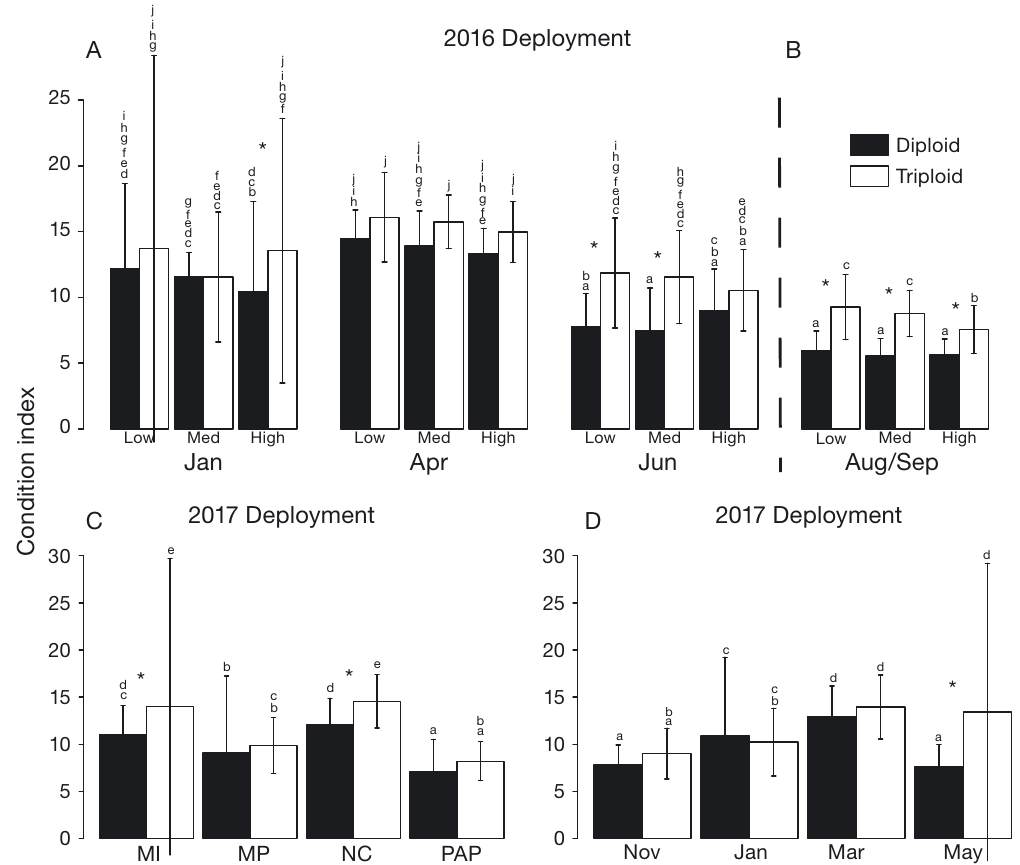
Fig. 6. Mean (±SD) oyster condition index for (A) 2016 deployment (n = 13) density × ploidy × collection date interaction, (B) August/September 2016 density × ploidy interaction, (C) 2017 deployment (n = 5) ploidy × oyster farm location interaction, and (D) 2017 deployment ploidy × collection date interaction. Letters indicate significant differences (Tukey post hoc test, p < 0.05); asterisks highlight paired ploidies in which triploid condition index was significantly higher that